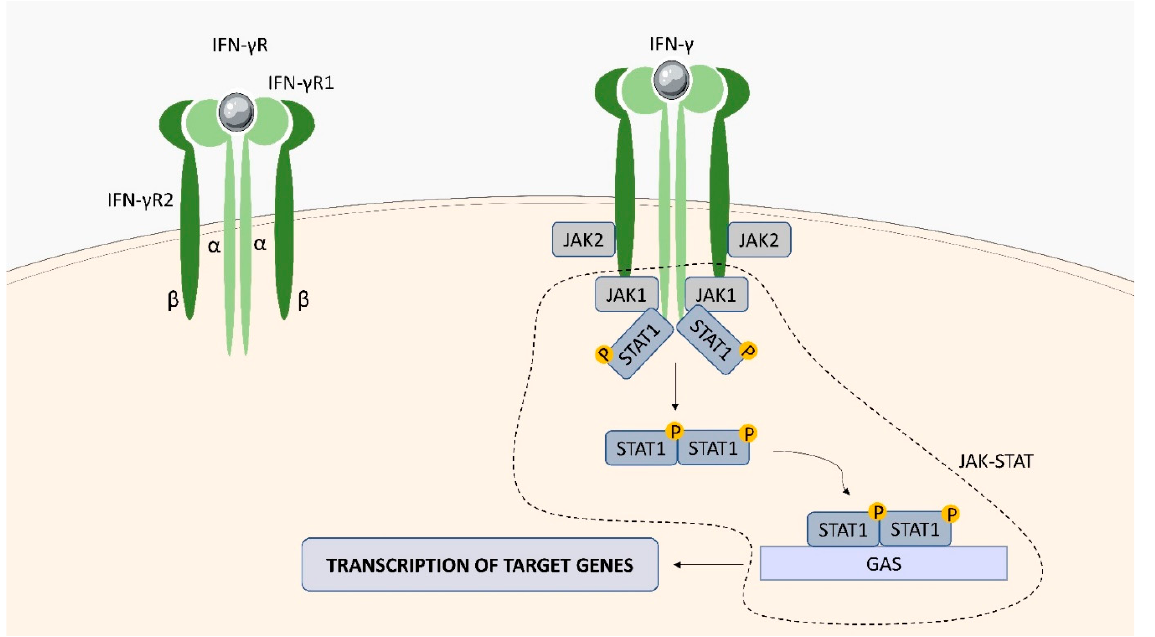
Figure 7. IFN- γ R structure and signaling. IFN- γ R consists of two β chains (IFN- γ R2) and two α chains (IFN- γ R1). The interaction of IFN- γ with IFN- γ R activates the JAK1/JAK2 tyrosine kinases. The JAK-STAT pathway is activated, which stimulates the transcription of genes in the cell nucleus, leading to the production of cytokines.